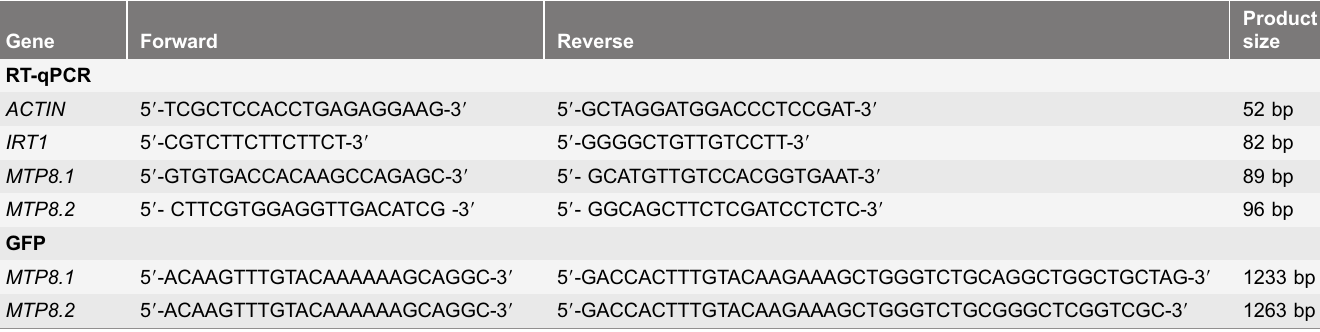
Table 2. List of primers used for RT-qPCR and GFP fusion constructs.